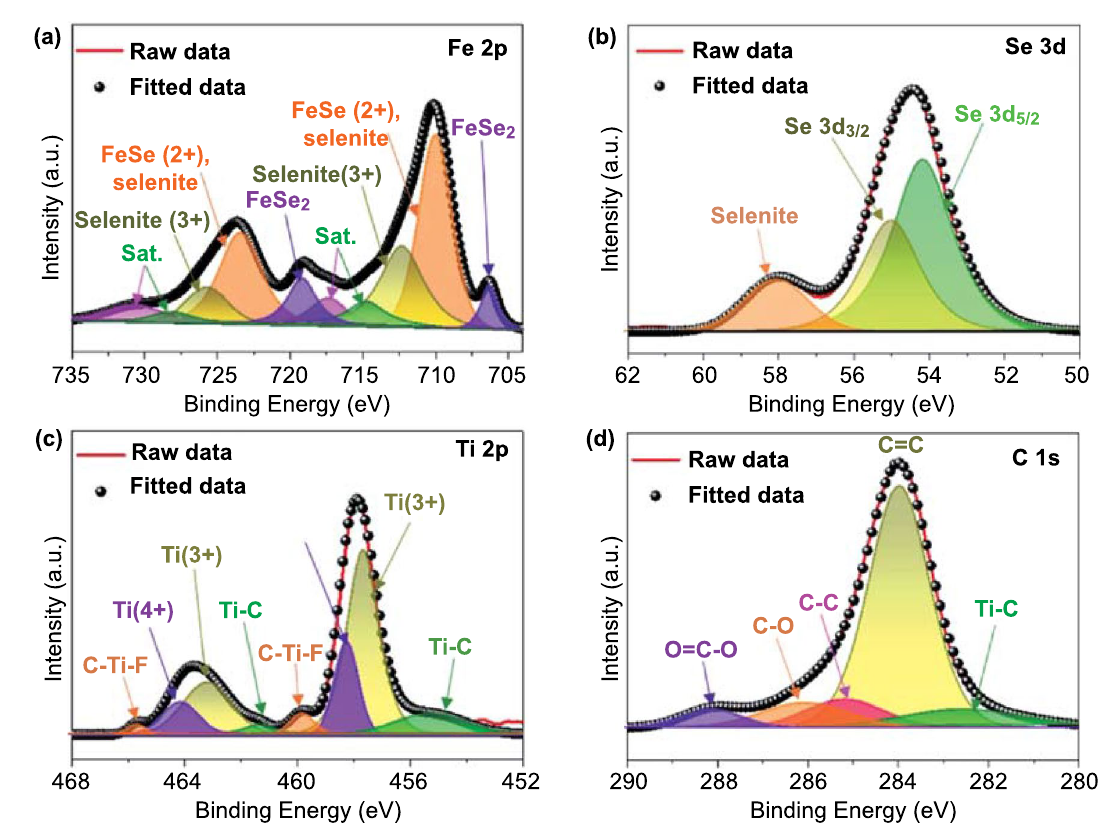
Fig. 2 XPS spectra of FeSe x @C/MB: a Fe 2p, b Se 3d, c Ti 2p, and d C 1s